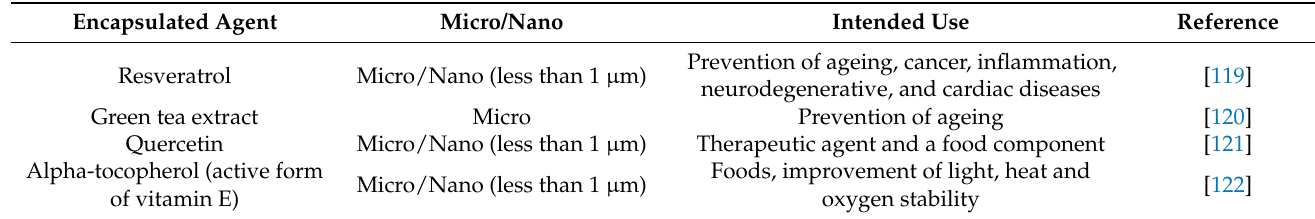
Table 4. Some indicative uses of particles for